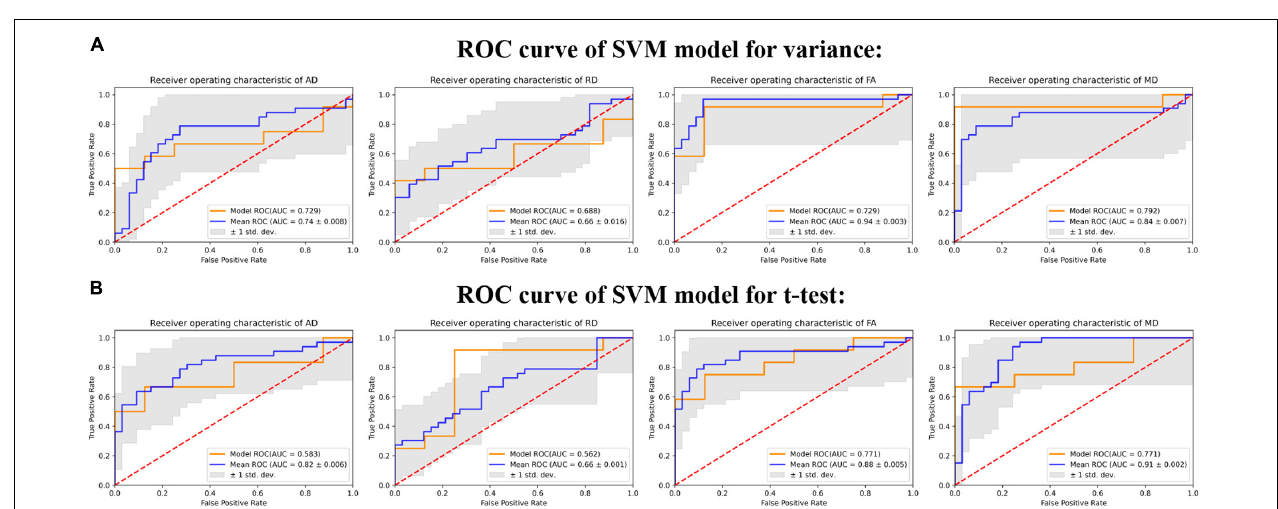
FIGURE 2 | The ROC curves of different DTI-derived indexes in support vector machine (SVM) model. The figure depicts the ROC curve of the trained model (yellow curve) and the average ROC curve (blue curve) of the model after leave-one-out cross-validation (LOOCV), and the shaded part represents the standard deviation (SD) of area under the curve (AUC). (A) Shows the results of training the model with four DTI parameters after feature selection by variance filtering method (variance threshold = 1). (B) Shows the results of training the model with four DTI parameters after feature selection by two sample t -test ( p < 0.05).